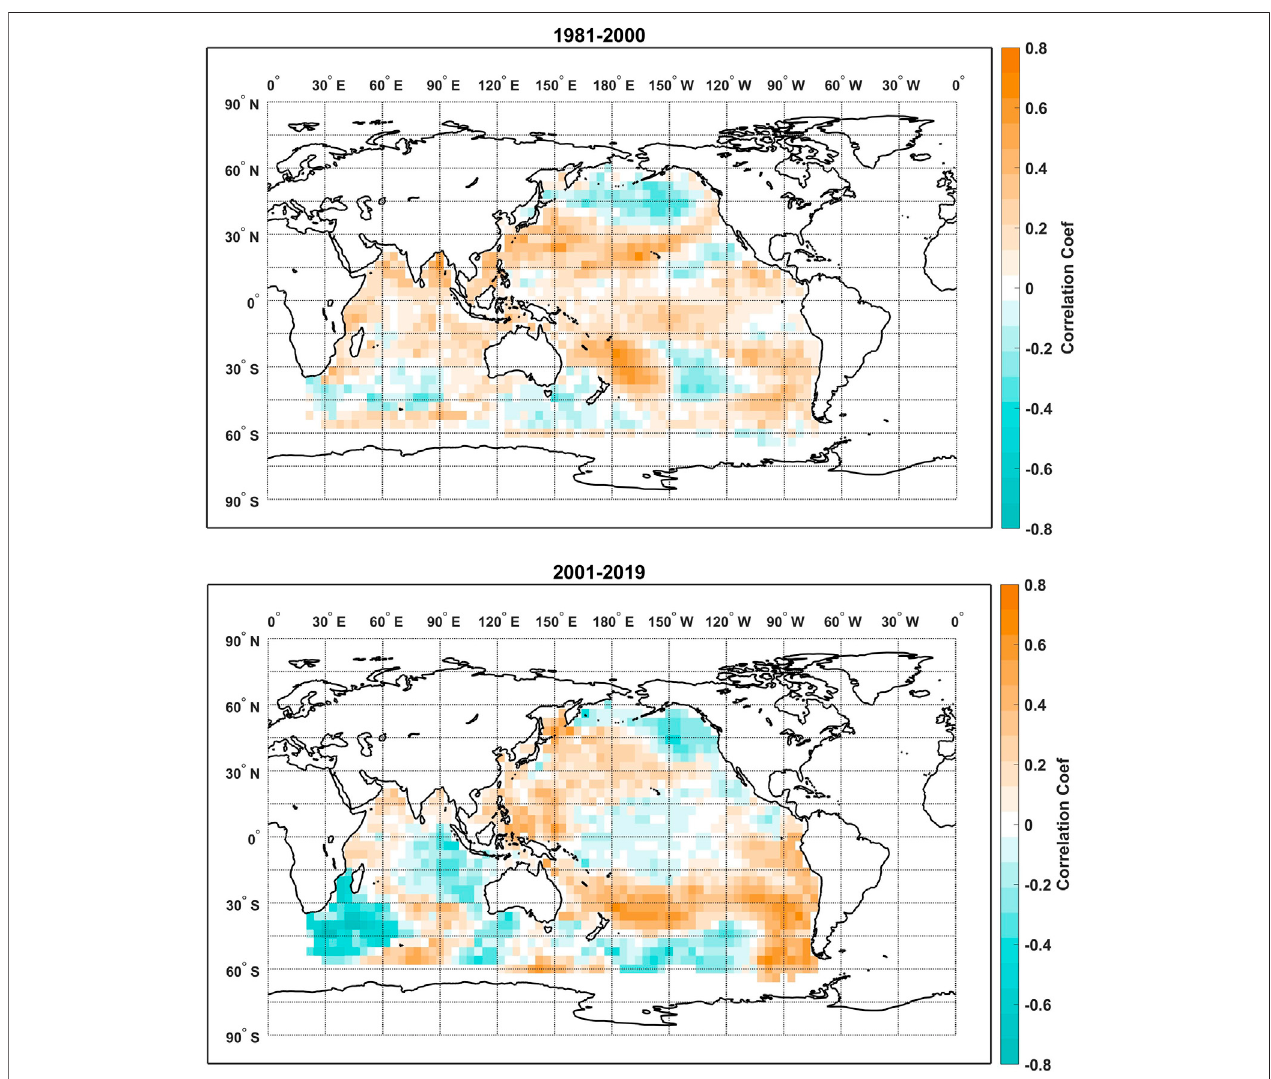
FIGURE 7 | Correlation maps between the TRHR precipitation and the SSTs over the training period of 1981 – 2000 (top) and the testing period of 2001 – 2019 (bottom) at the lead time of 14 months.